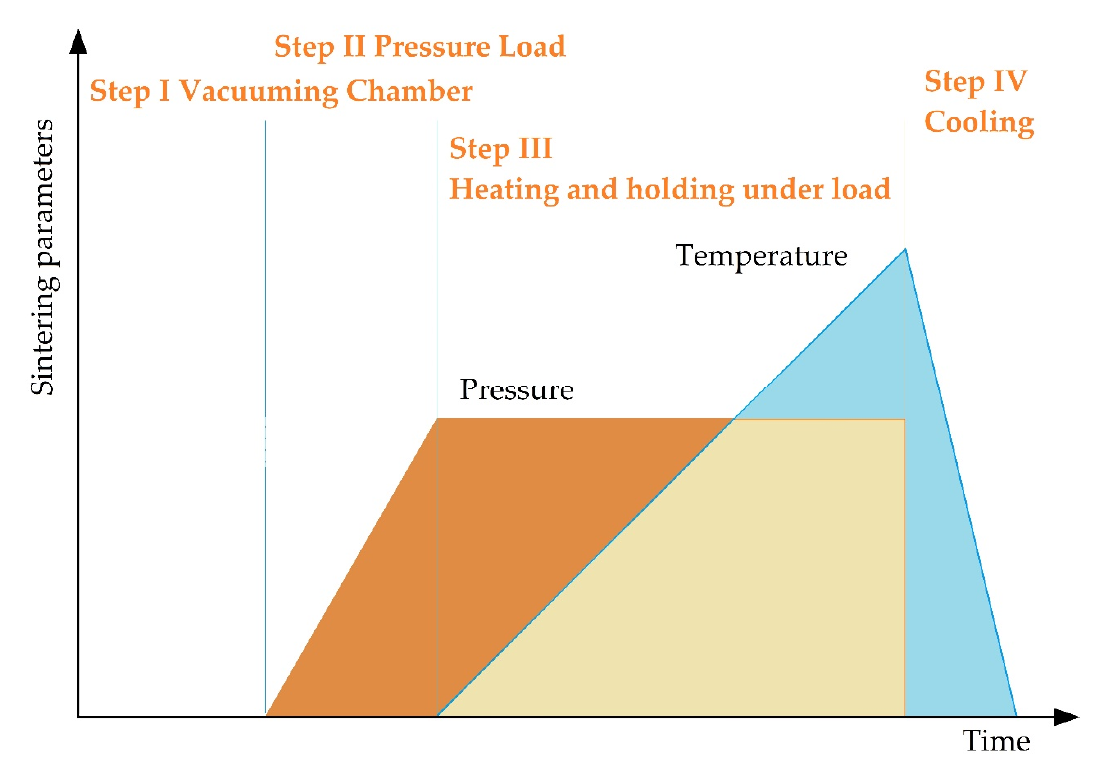
Figure 7. The main stages of spark plasma sintering.